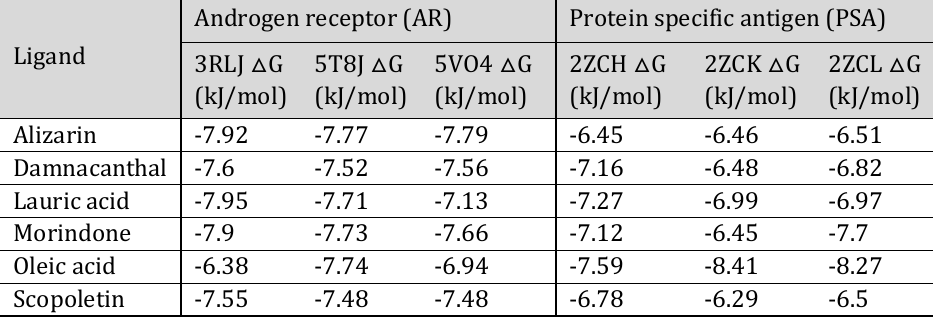
Table 2. Molecular docking of the investigated Morinda citrifolia phytochemicals against target proteins using